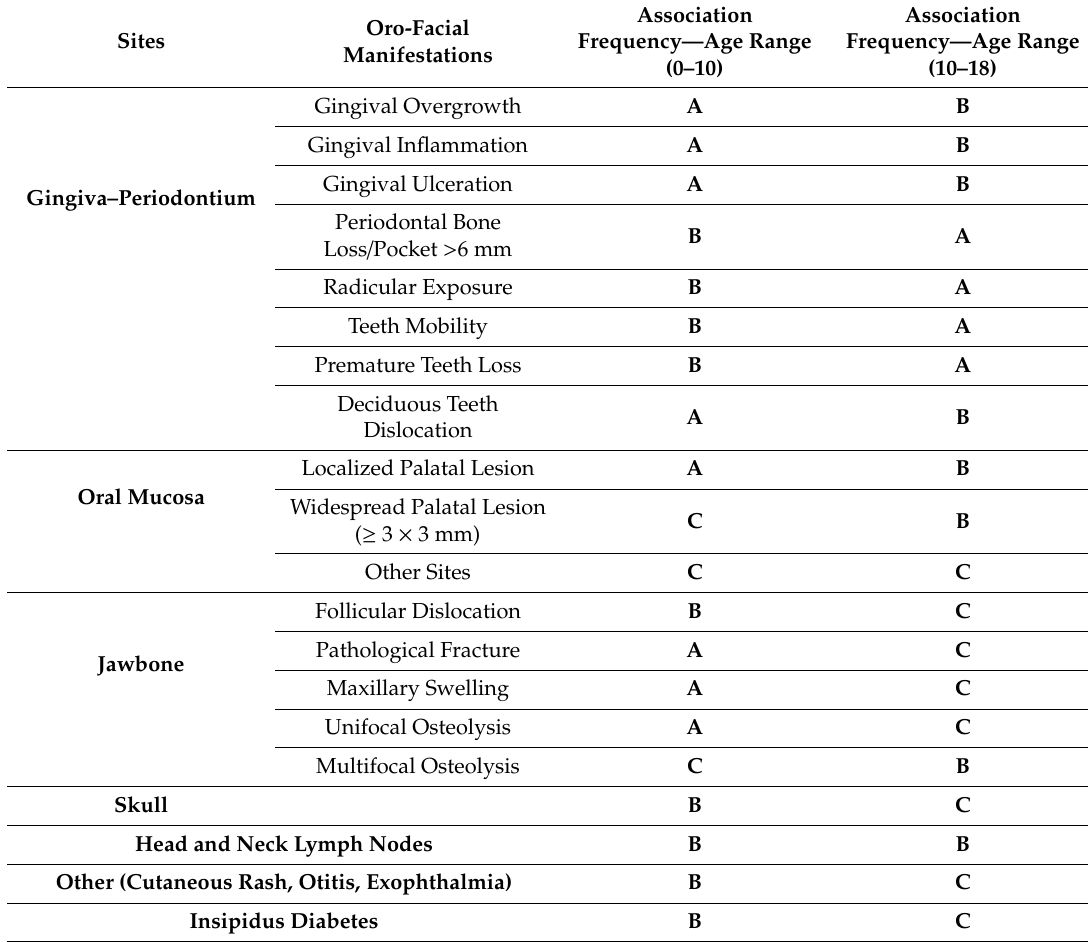
Table 1. Association frequency (range value) * of early / primary Dento / Oro / Facial clinical–radiological manifestations of LCH among our pediatric